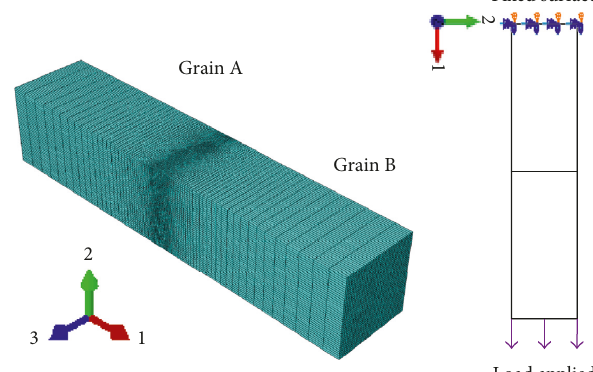
Figure 1: Type-I grain boundary: GB perpendicular to thetensile axis.